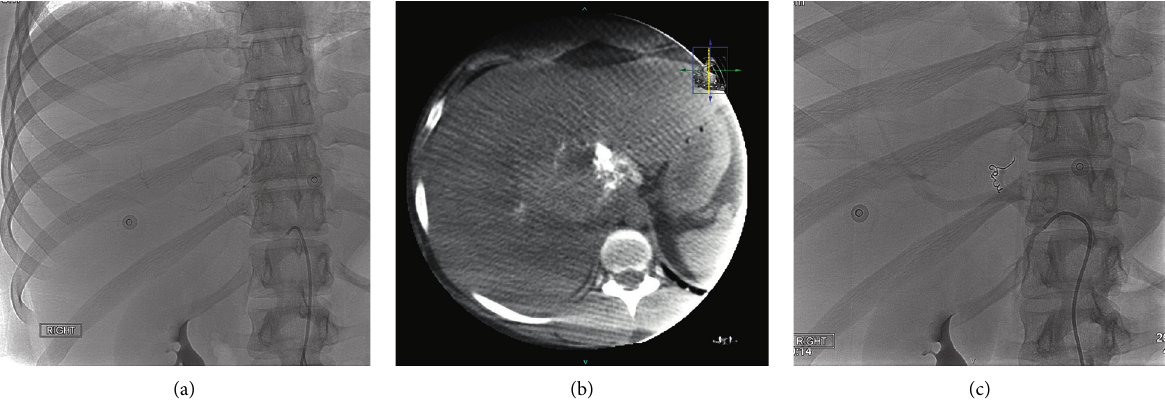
Figure 2: (a) Subselective catheterization of the hepatic artery, segment 8 branch with arteriography. (b) Cone beam CT demonstrating patency and perfusion of the hepatic adenoma. (c) Coil embolization of segment 8 branch of the hepatic